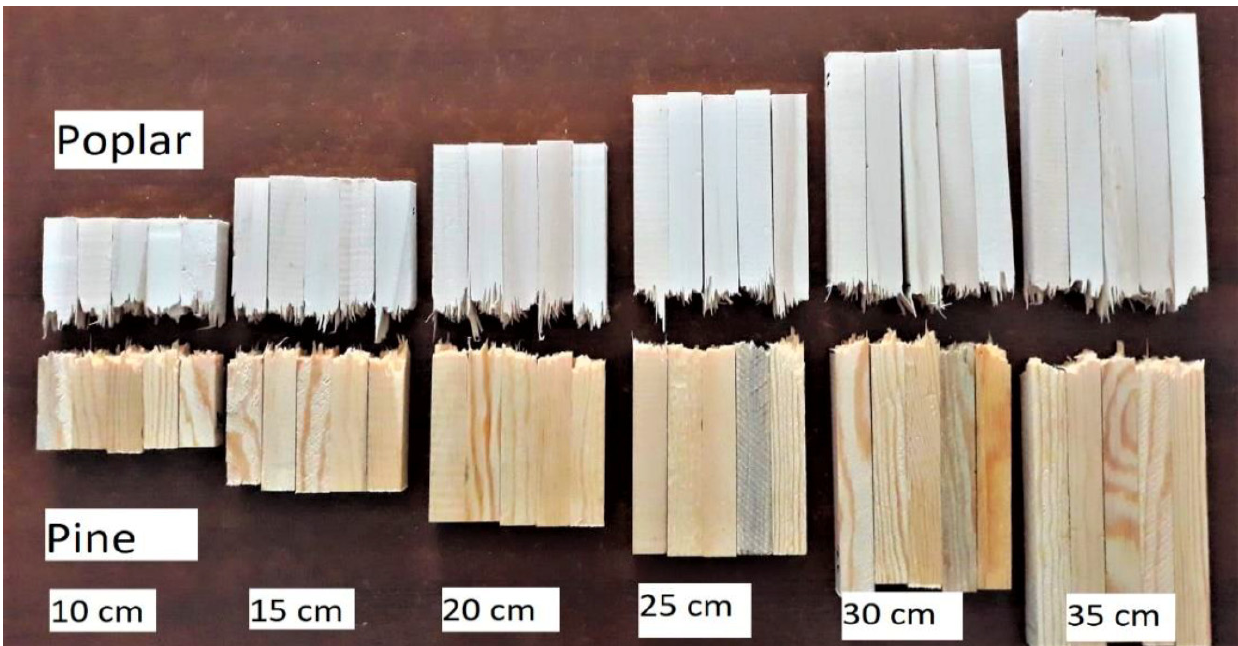
Figure 46. Photographs of groups of five test specimens of Poplar and Pine wood that had been subjected to an impact bending strength test. The labels give the span lengths of the original specimens in each group. From [166].